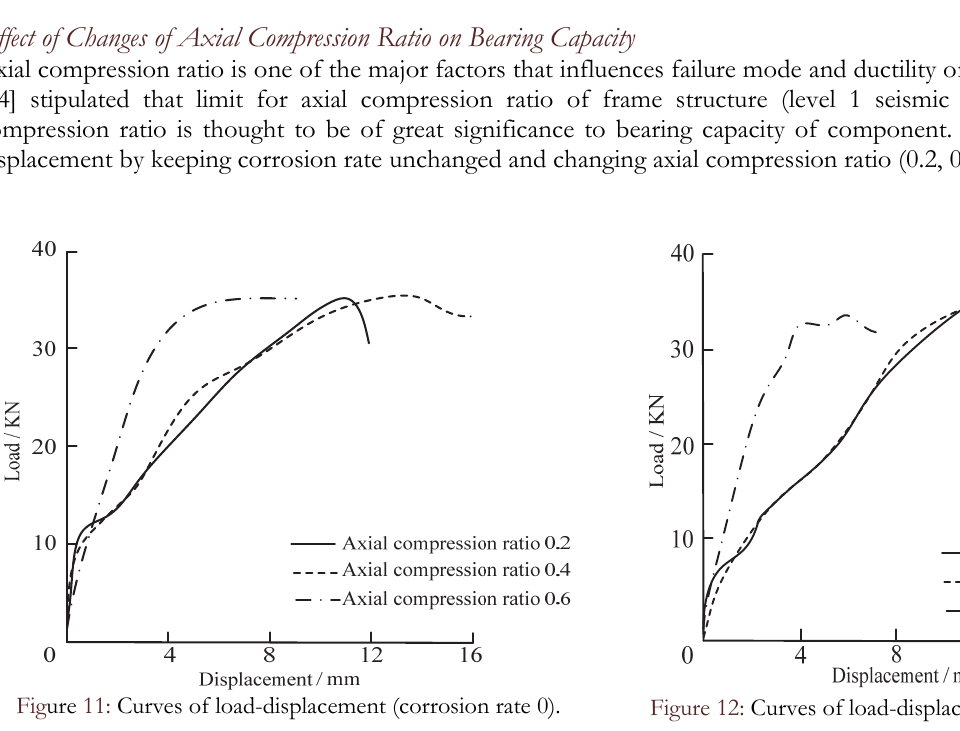
Effect of Changes of Axial Compression Ratio on Bearing Capacity